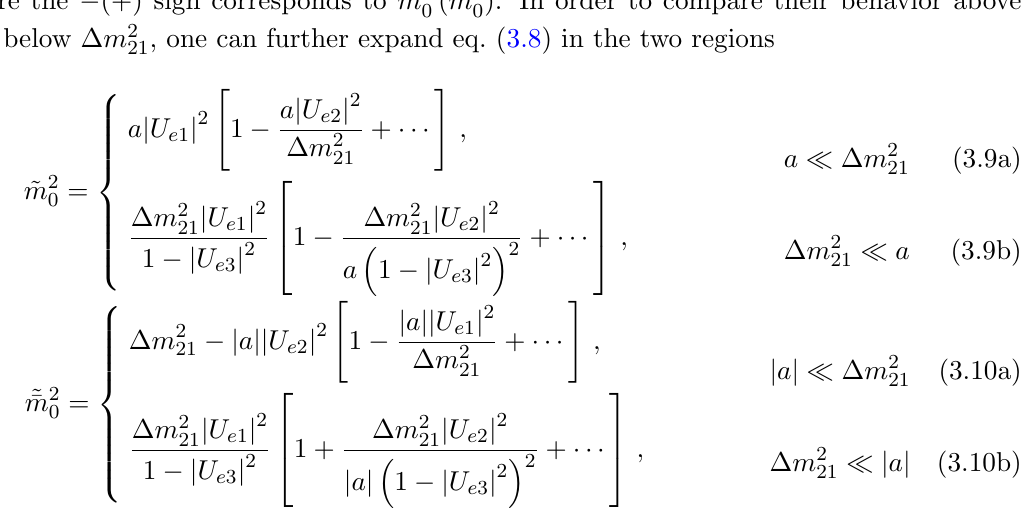
and ~(cid:22) m 2 , on the other hand, comes from neglecting (cid:1) m 2 0 0